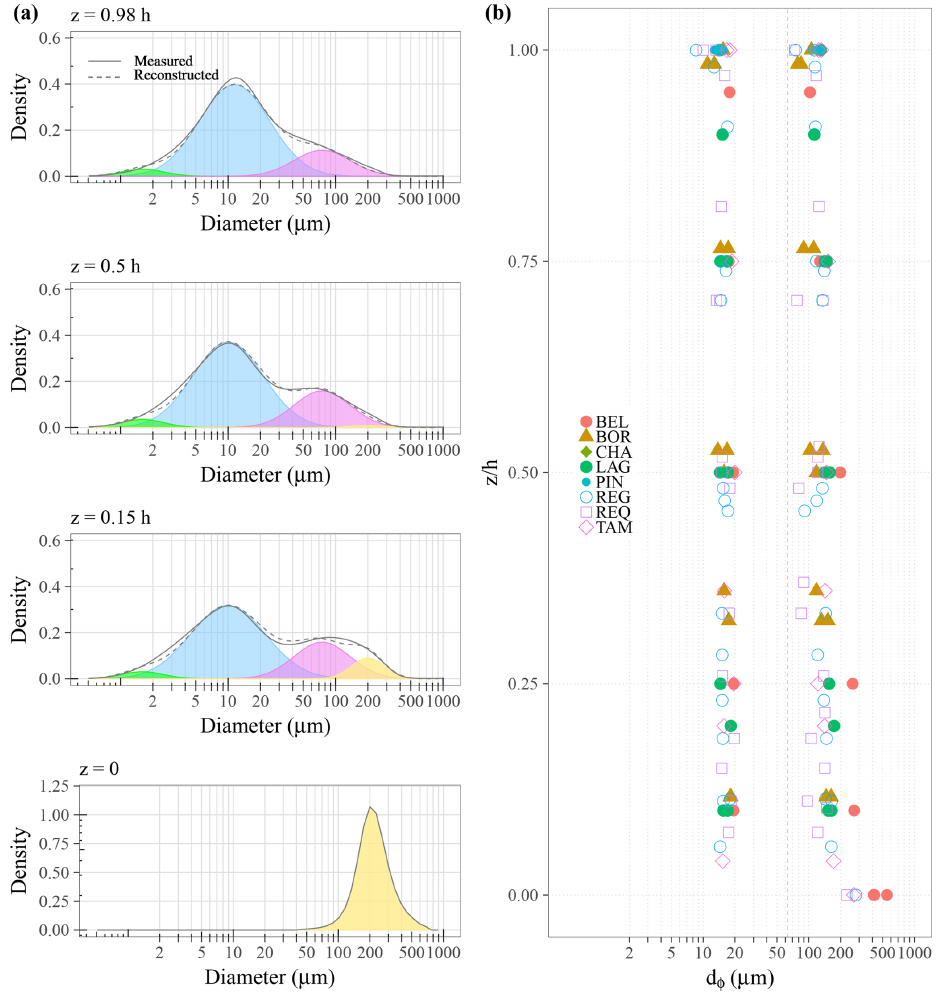
Figure 4. (a) Multimodal modeling of a typical PSD vertical profile. Gray lines represent the PSD measured at the Requena gauge station (16 March 2015) on the Ucayali River. Sampling depths are mentioned on top of each panel. Green, blue, pink and yellow roughly correspond to the following particle size groups: clays, silts and flocculi, very fine sands–fine sands, and bed material, respectively. The dashed gray line is the sum of the subdistributions. (b) Particle diameters d φ measured at the eight sampling stations for the fine and sand